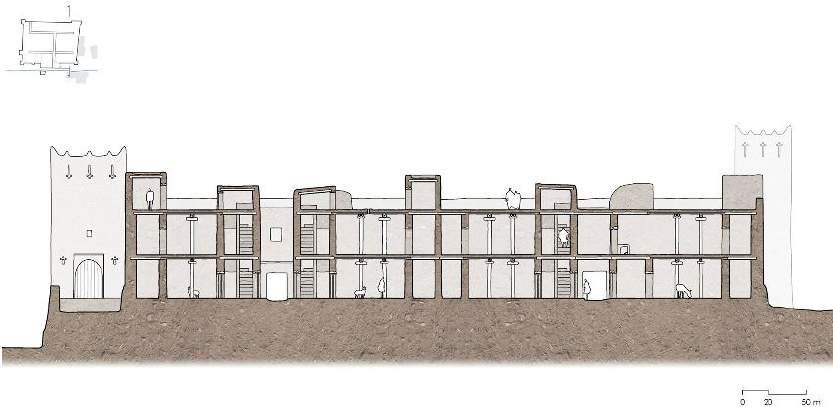
Figure 6. Tabenaatout Ksar. Section, Outat Valley.